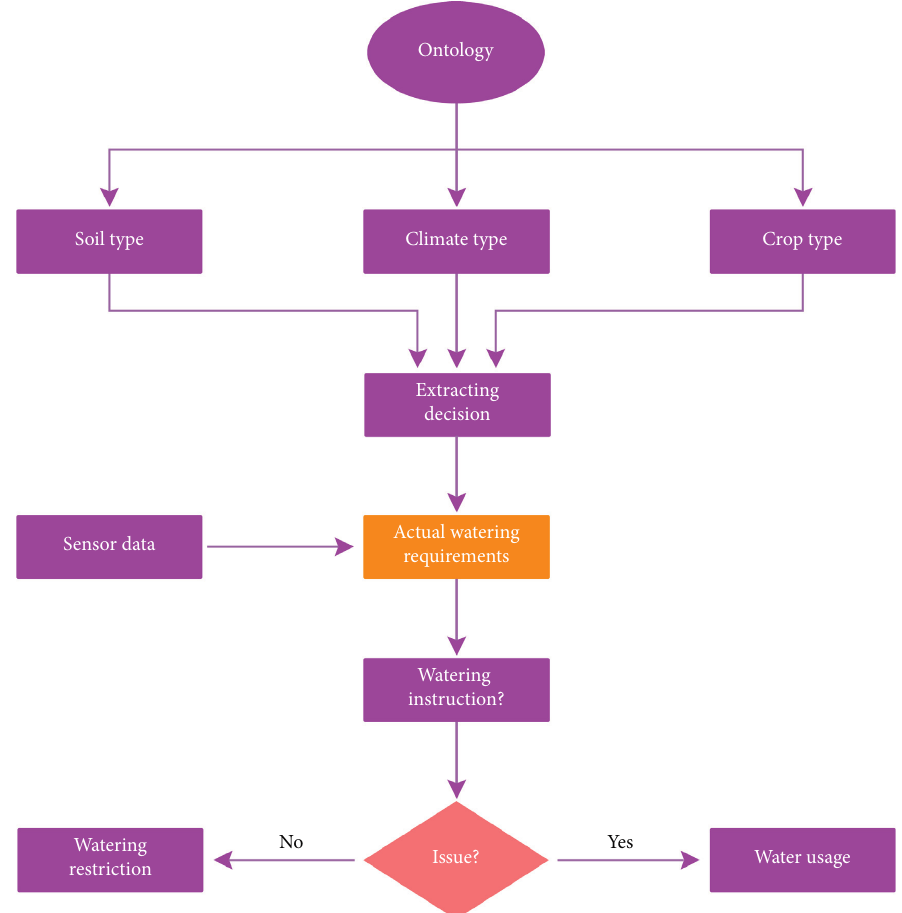
Figure 4: Inference rule